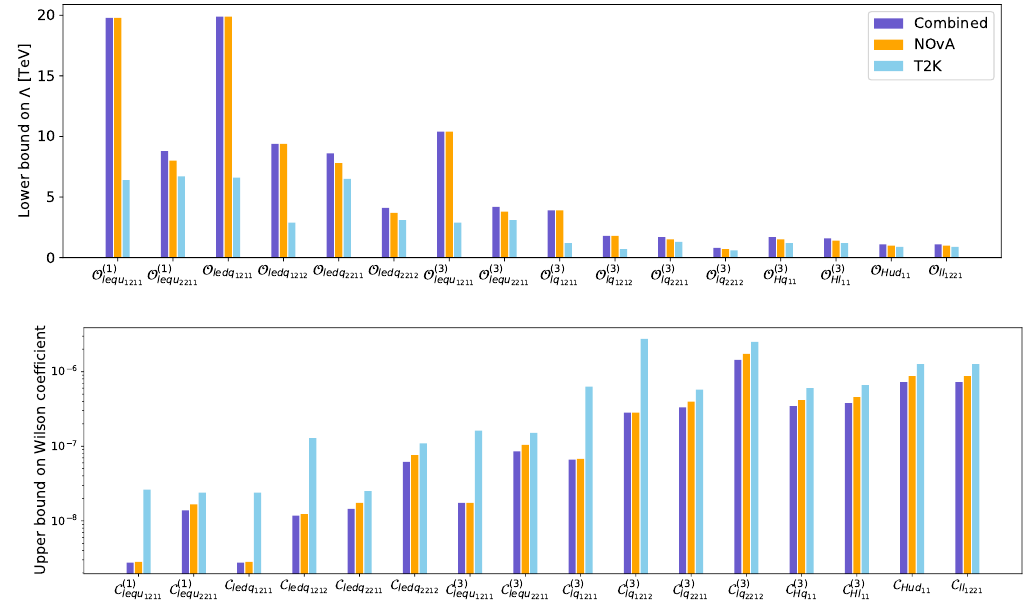
Figure 8 . Constraints on a part of dimension-6 operators in tables 5 and 6 in LBL experiments T2K and NO ν A at 95% CL of statistical significance. The lower bounds are presented on the UV scale Λ in each operator, when the corresponding Wilson coefficient is set to unity. Correspondingly, the upper constraints on the respective Wilson coefficients are shown when the scale is set to Λ = 1